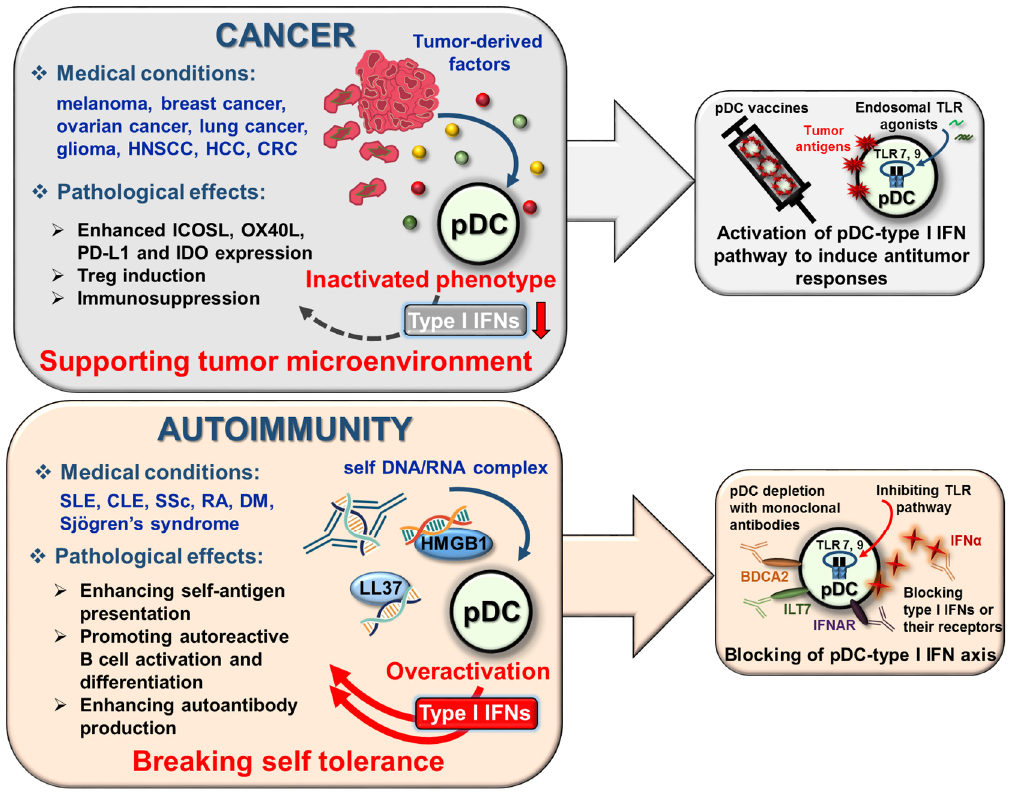
Figure 3. pDC-type I IFN axis is implicated in the pathogenesis of cancer and autoimmunity. Due to the suppressive tumor-derived factors, pDCs are the “sleeping beauties” of tumor microenvironments, and thus are unable to use their valuable anti-tumor activity, which further supports tumor growth. Therefore, reawakening of pDCs with different endosomal TLR ligands might elicit their direct and indirect type I IFN-dependent antitumor responses. Furthermore, tumor antigen-loaded pDCs represent promising vaccine candidates as well ( upper panel ). On the contrary, overactivation of pDCs maintains a prolonged interferon gene signature (IGS) and fuel autoimmunity. Thus, in the therapy of pDC-associated autoimmune diseases the main goal is to reduce the activity of the pDC-type I IFN axis using monoclonal antibodies, which deplete or inhibit pDCs, neutralize circulating IFN α or block IFNAR receptors. TLR7/9 antagonists are also undergoing trials in the treatment of these disorders ( lower panel ). BDCA2: blood dendritic cell antigen 2; CLE: cutaneous lupus erythematosus; CRC: colorectal cancer; DM: diabetes mellitus; HCC: hepatocellular carcinoma; HMGB1: high mobility group box protein 1; HNSCC: head and neck squamous cell carcinoma; ICOSL: inducible T cell costimulator ligand; IDO: indoleamine-2,3- dioxygenase; IFN: interferon; IFNAR: interferon-alpha/beta receptor; ILT7: immunoglobulin-like transcript 7; OX40L: OX40 ligand; pDC: plasmacytoid dendritic cell; PD-L1: programmed cell death protein 1; RA: rheumatoid arthritis; SLE: systemic lupus erythematosus; SSc: systemic sclerosis; TLR: Toll-like receptor; Treg: regulatory T cell